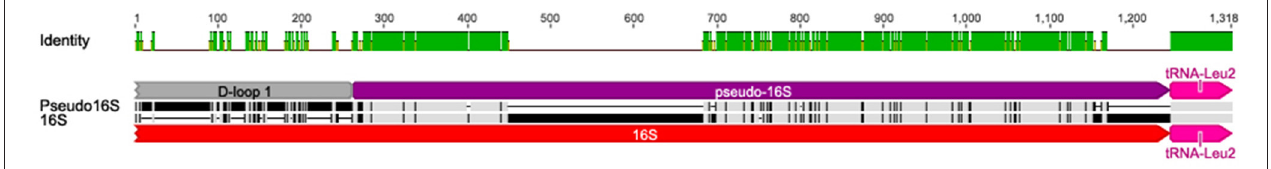
FIGURE 7 | Pairwise MUSCLE alignment of part of 16S rRNA to the pseudo-16S rRNA region in the A. limnaeus mtgenome. The pseudo16S region is located between Alim-D-loop 1 and Alim-D-loop 2. The alignment reveals regions of high similarity between the 16S rRNA and the pseudo-16S. Relative to the reference mtgenome sequence, the pseudo16S region shown here is from positions 4814 to 5812 and the 16S region is from 2227 to 2791.